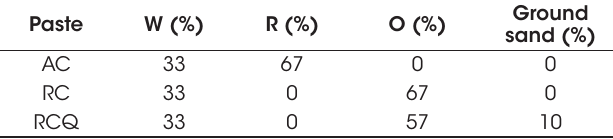
Cement paste composition: AC, RC, and RCQ